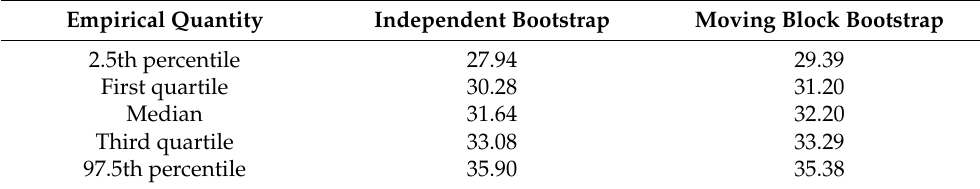
Table 2. Empirical distributional quantities of the sample mean based on the independent bootstrap (blue—incorrect approach) against moving block bootstrap (red—proper approach) for the Danish Fire Insurance Claims belonging to the reinsurance layer starting from 20M DKK (Danish crowns) up to 100M DKK; number of observations n =